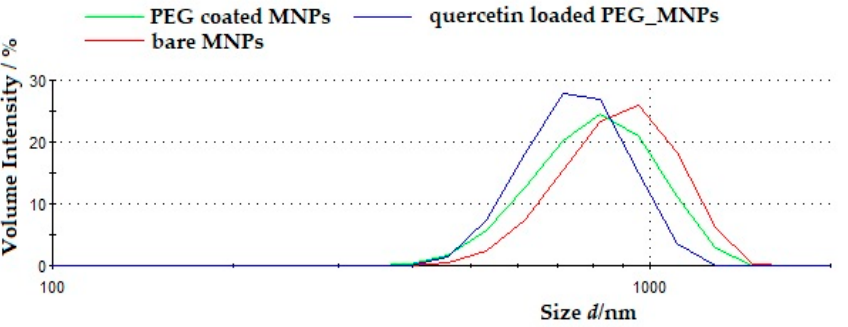
Figure 7. Volume size distributions of bare MNPs, PEG-coated MNPs and quercetin-loaded PEG_MNPs.